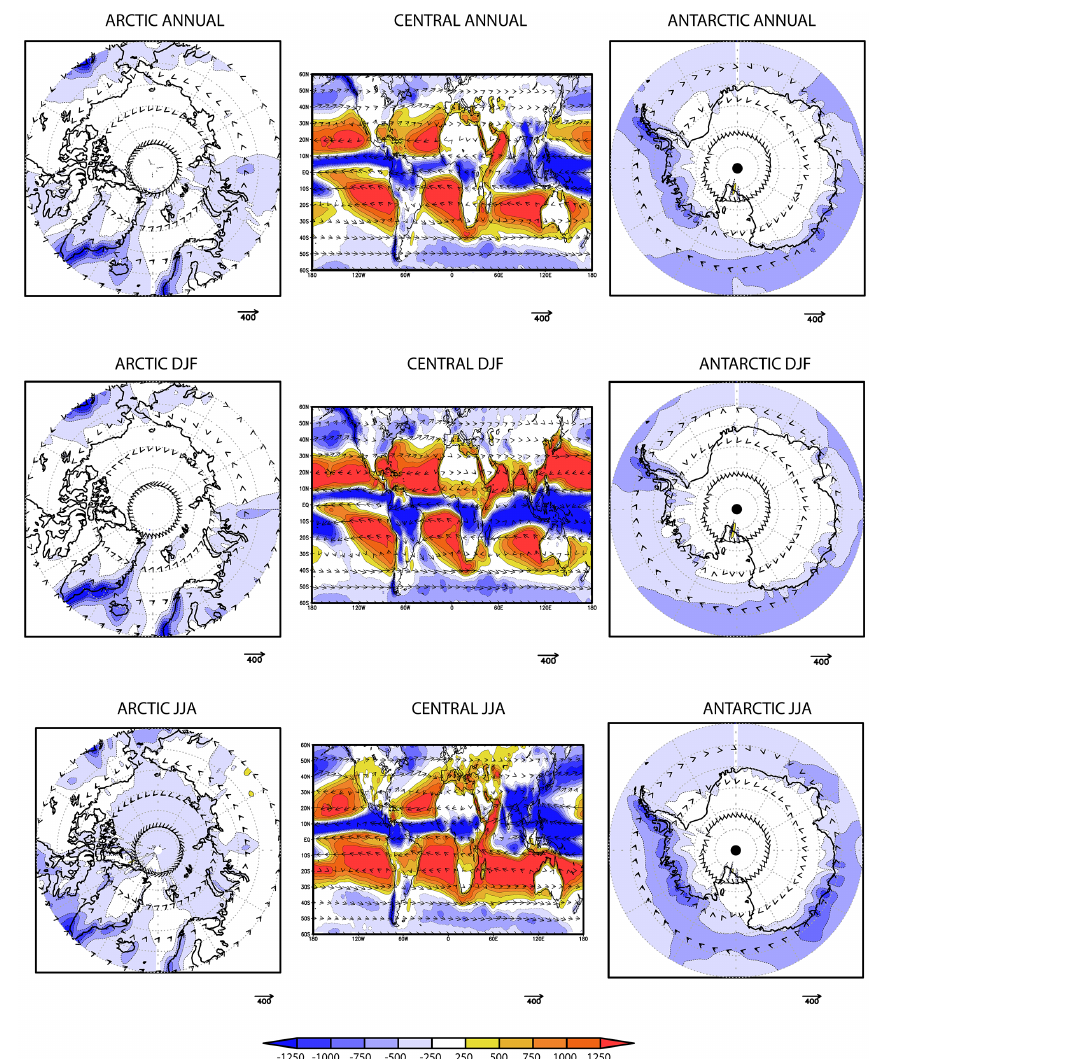
Figure 2. Vertically integrated moisture flux (vector, kgm − 1 s − 1 ) and its respective divergence (shaded, mmyr − 1 ) in the Arctic (left-hand column), the Central (central column), and the Antarctic (right-hand column) domains for the annual (top row), DJF (central row), and JJA (bottom row) temporal means for the period 1980–2012. Data: